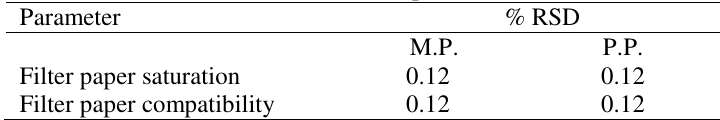
Table 1. Validation